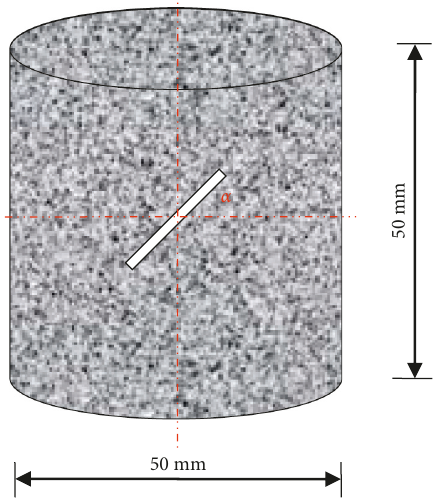
Figure 1: Size of a fissured rock